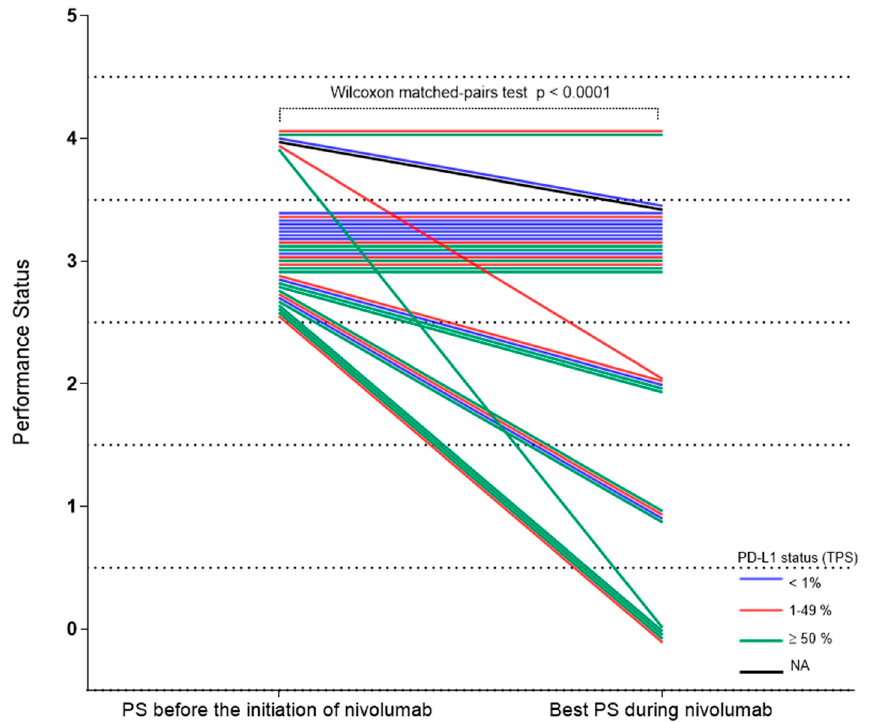
Figure 4. Change of performance status upon nivolumab. Change of performance status for each patient during nivolumab treatment, by PD-L1 status. PD-L1, programmed death-ligand 1; PS, performance status.